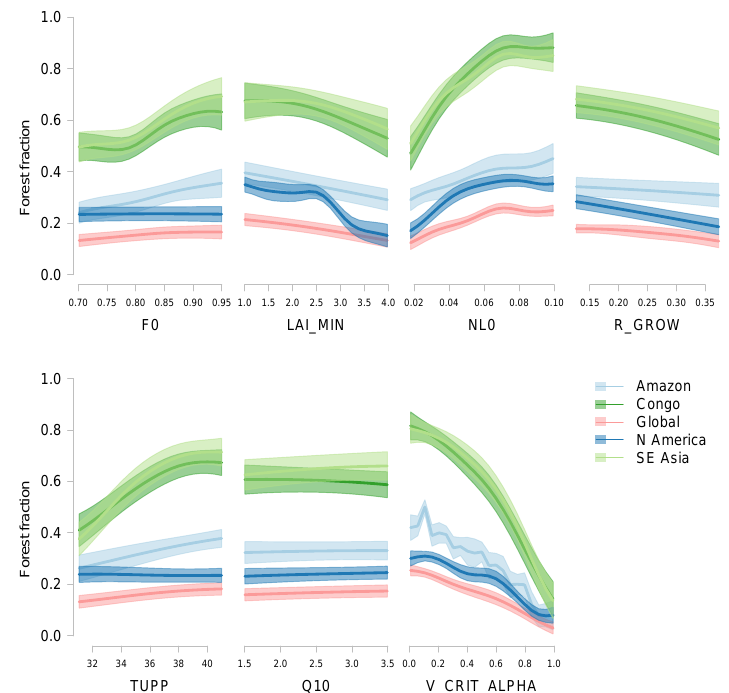
Figure 6. Marginal sensitivity of mean forest fraction to each input parameter in turn, with all other parameters held at standard values. Central lines represent the emulator mean, and shaded areas represent the estimate of emulator uncertainty, at the ± 1SD level.